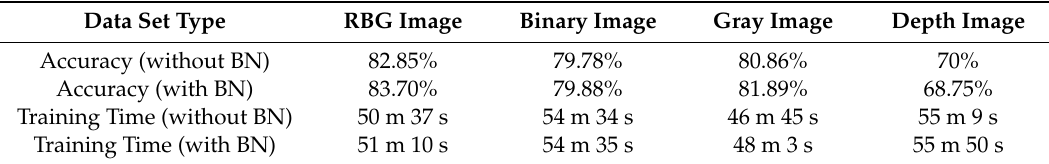
Table 2. Comparison results for the four data